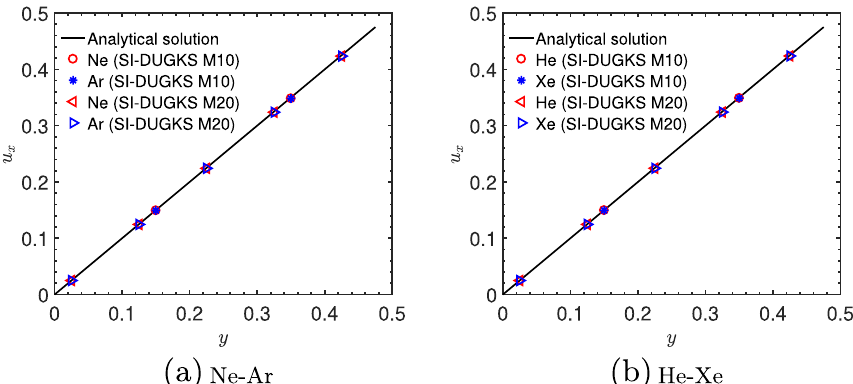
Fig. 15 Velocity profiles in the Couette flow with 𝛿 = 5000 . M10 and M20 represent the results with 10 and 20 mesh points in the y direction,